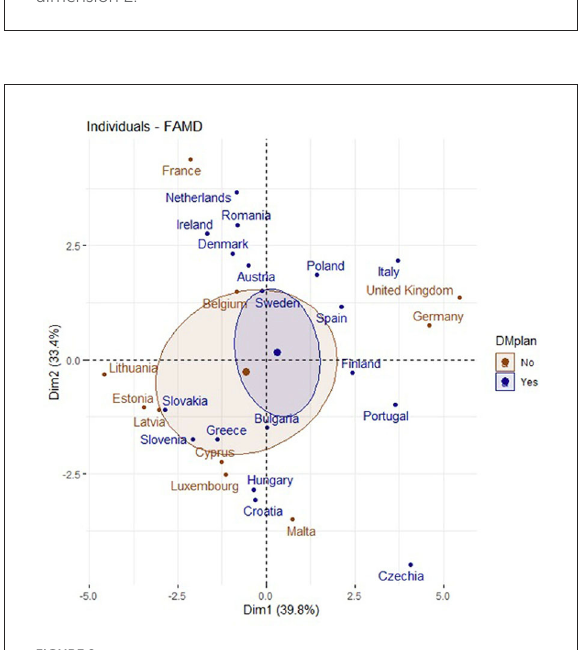
FIGURE9 Countries with a NHPs and dimension 1 and dimension